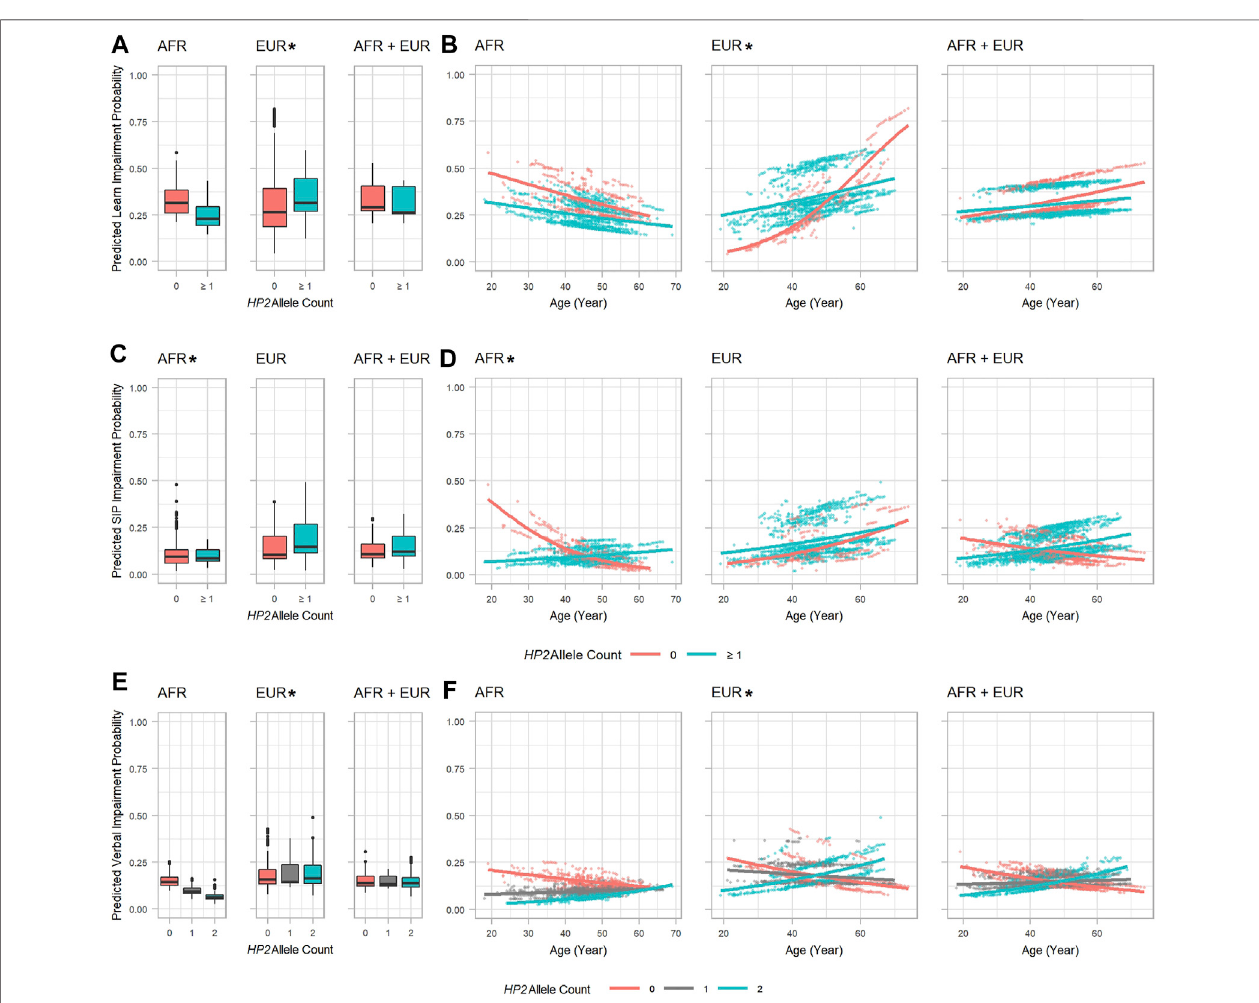
FIGURE3 | HP2 effecton predicted speci fi ccognitive domain impairment probability in theAFR and EUR participants. (A, C) and (E) : Boxplots showing the effect of HP2 on predicted learning, SIP, and verbal domain impairment probabilities, respectively. (B, D) , and (F) : Scatter plots with trendlines showing the effect of age on predicted learning, SIP, and verbal domain impairment probabilities, respectively. (A, B) are from the model in Supplementary Table S6 . (C, D) are from the model in Supplementary Table S8 . (E, F) are from the model in Supplementary Table S7 . Plots are colored by HP2 status. Additional adjustment of the fi rst 3 PCs was used in AFR + EUR analyses. “ p ” indicates statistical signi fi